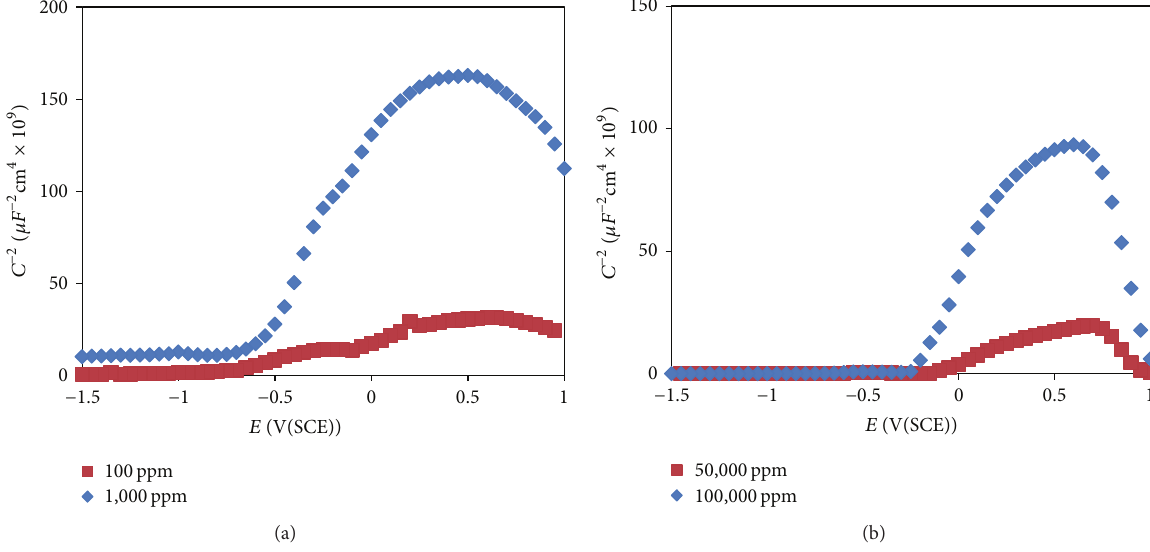
Figure 16: Effect of NaNO 2 addition on Mott-Schottky plot for the passive film formed in deaerated simulated cooling water at 25 ∘ C; (a) carbon steel at +400mV (SCE) and (b) ductile cast iron at 0 mV